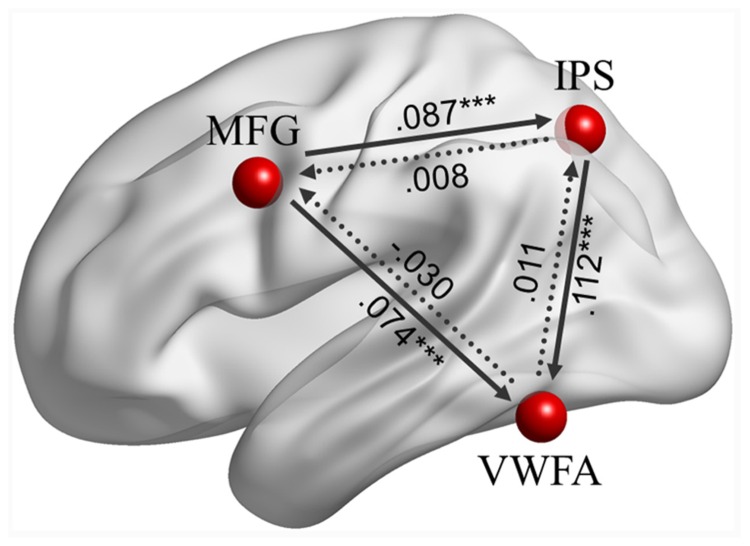
The effective connectivity (ECs) among the left MFG, left IPS, and VWFA during task-driven fMRI. Significant coefficients are at ∗∗∗p < 0.001, indicated by solid lines.